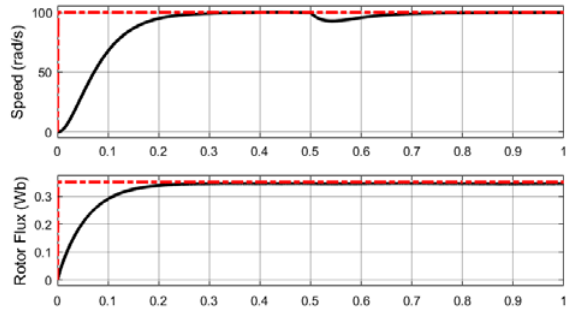
Fig. 2. Speed and rotor flux responses